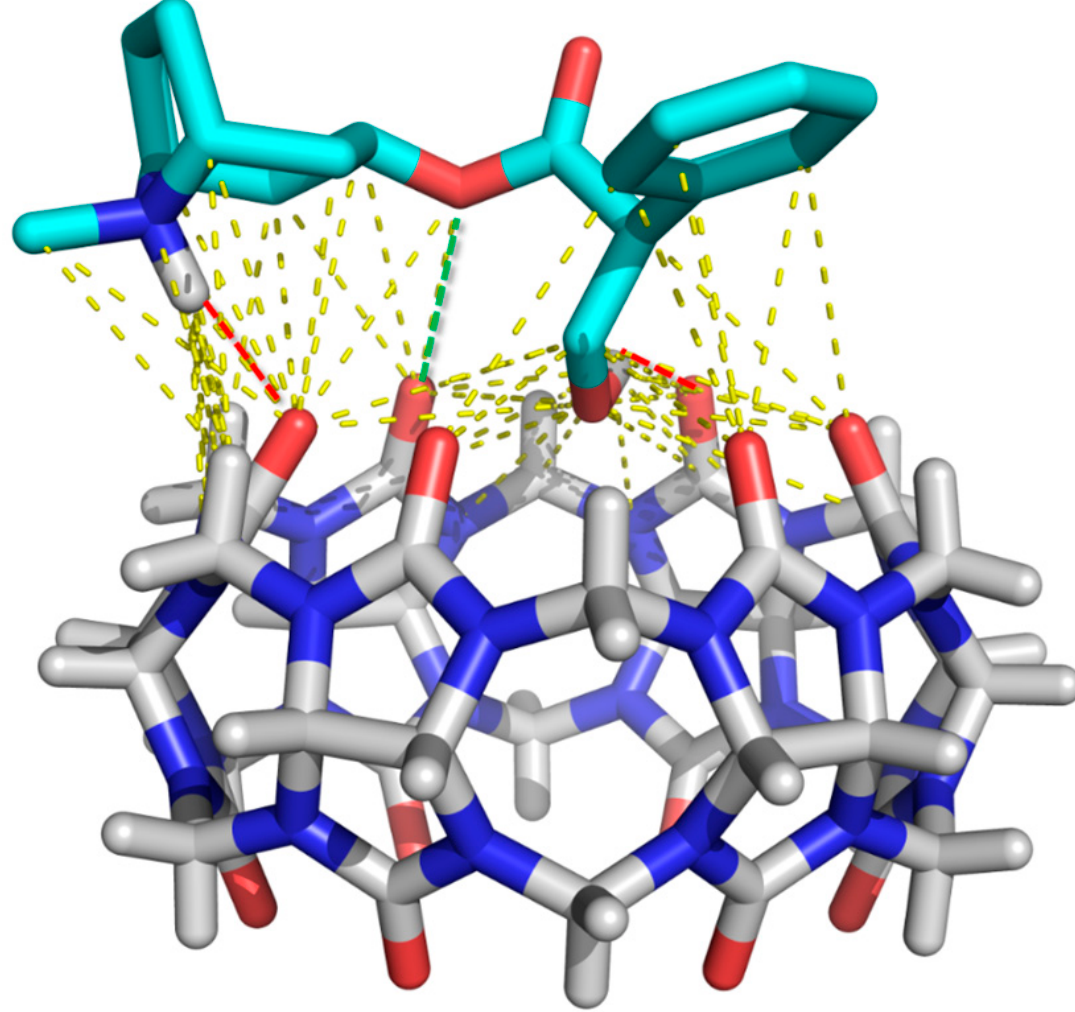
Figure 1. Crystallographic structure of CB[6] (CCDC deposition number 1540086) (white sticks) bound to docked atropine (light blue sticks). Hydrogen interactions and dipole–dipole interactions are represented as red and green broken lines. Other interactions (van der Waals, hydrophobic, dipole-induced dipole) are represented as yellow broken lines. Oxygens and nitrogens are represented in red and blue, respectively.